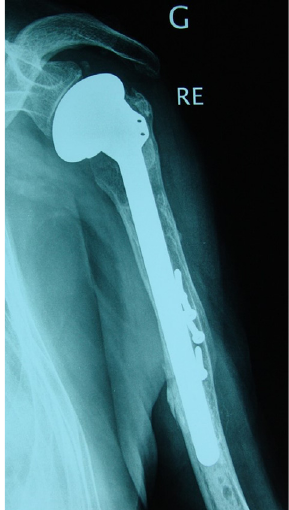
Figure 4. X-rays at 30 months follow-up confirmed satisfactory healing of both the tuberosities (without osteolysis) and of the humeral shaft fracture. No signs of stem or implant loosening were